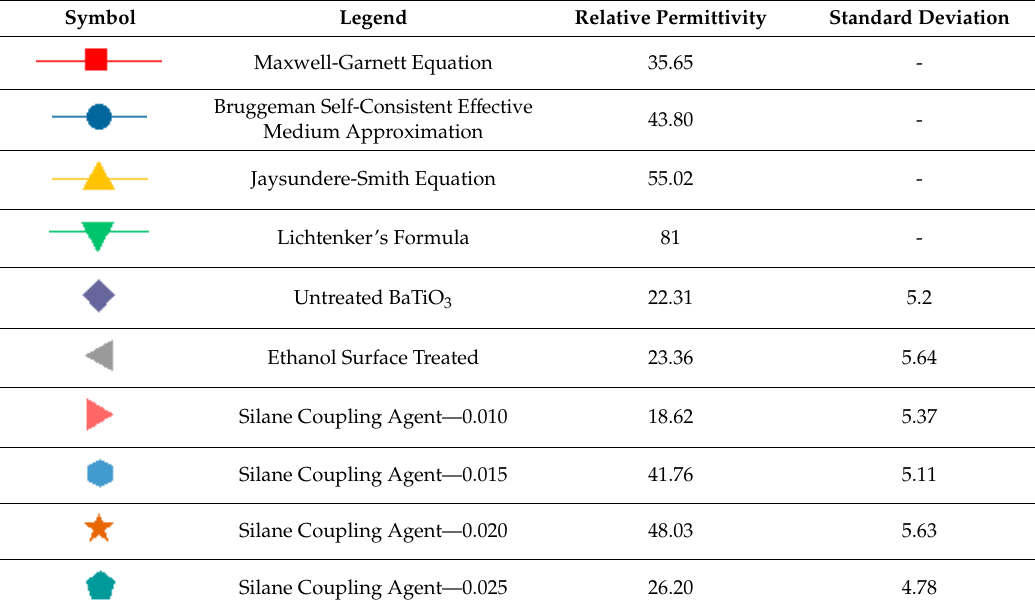
Table 3. Comparison of the relative permittivity of the theoretical models with different experimental results, where the readings were taken at 20 MHz for the composites that were prepared using 0.5 volume fraction of BaTiO 3 .